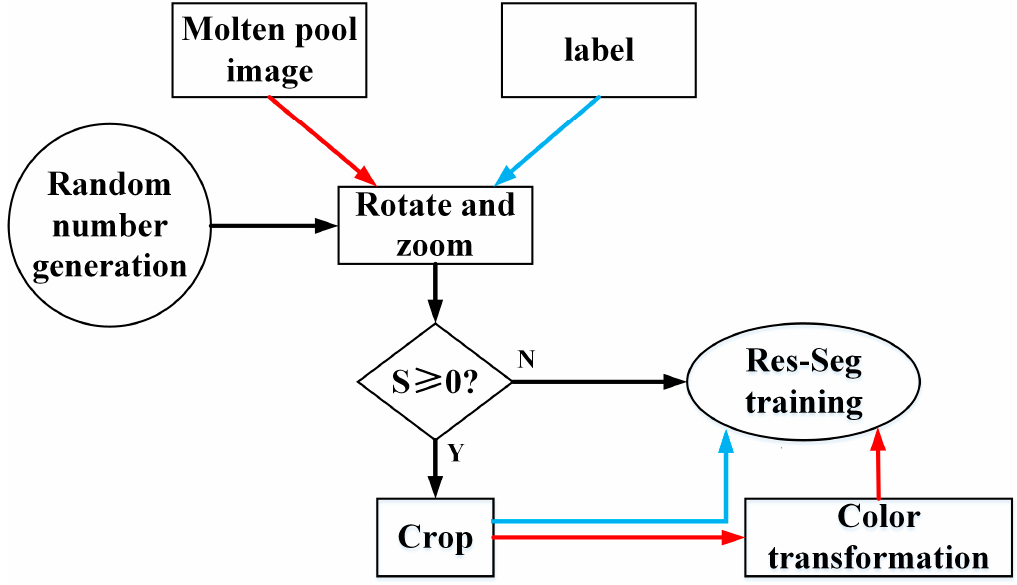
Figure 9. Flow chart of data augmentation process.